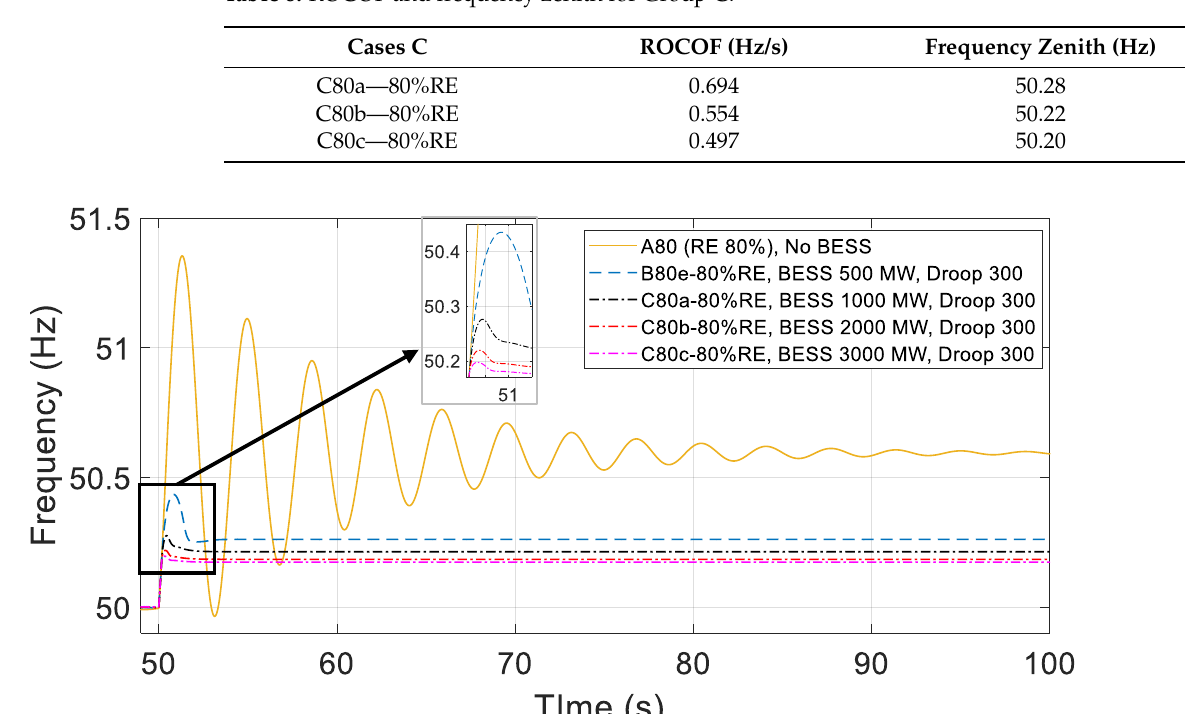
Figure 10. Frequency response of the system when different BESS capacities provide PFC using a fixed droop coefficient under an 80% RE penetration scenario.